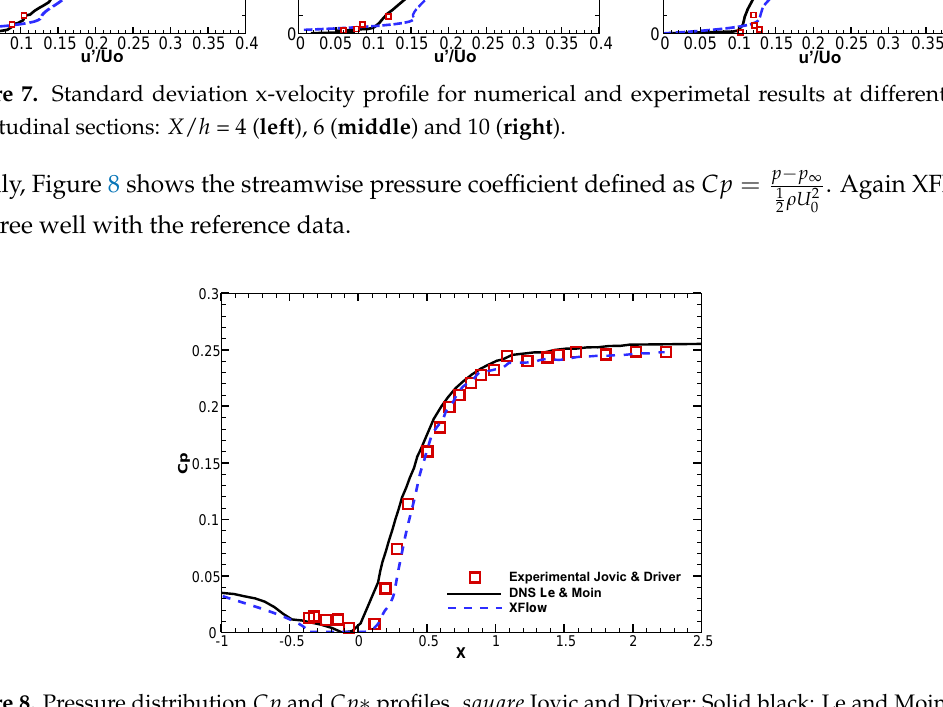
Figure 8. Pressure distribution Cp and Cp ∗ profiles. square Jovic and Driver; Solid black: Le and Moin (1997); DashDot Cyan: Finest, Solid Green: Medium, Dashed Blue: